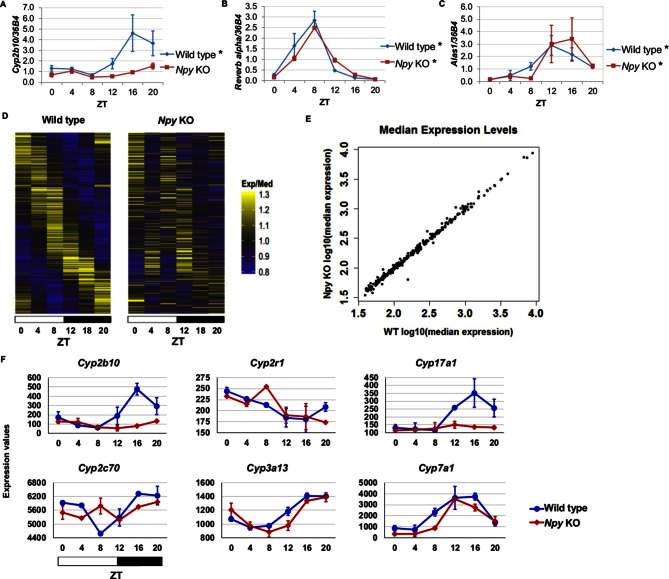
Npy regulates circadian expression of cytochrome P450 genes in the murine liver.(A–C) Quantitative PCR analysis in murine livers. Daily oscillations of Cyp2b10 expression (A) are abolished in Npy KOs compared to their background controls (wild type), while oscillations of the circadian gene, Reverb alpha (B), are unaffected. (C) Levels of another liver clock-independent gene, Alas1, are similar in wild type and Npy KO, suggesting Npy does not regulate its rhythmicity. For qPCR data, n=3–4 mice for each genotype and time point. Transcript levels were normalized to the housekeeping gene 36B4. (D–F) Microarray analysis was used to detect transcript expression in livers of Npy KO and their background controls collected over the course of 24 hr in LD. (D) The heatmap includes transcripts that oscillate in wild type but not in Npy KO liver. Data represent the average transcript abundance from n=2 samples for each genotype and timepoint. Here, the MetaCycle p-value cutoff of p<0.01 was used to identify cyclic transcripts; p>0.8 was considered not cyclic. (E) The median expression values of the wild type-only cyclic transcripts are not different between Npy KO and wild type. (F) Daily expression values of cytochrome P450 genes from microarrays. Cytochrome P450 genes Cyp2b10, Cyp2r1, Cyp17a1, and Cyp2c70 are cylic in wild type liver but are not cyclic in Npy KO liver. Cyp3a13 and Cyp7a1 cycle robustly in both wild type and Npy KO. Graphs show average ± SEM. ZT- Zeitgeber Time.DOI:
http://dx.doi.org/10.7554/eLife.13552.01310.7554/eLife.13552.014Figure 5—source data 1.Data for qPCR and microarray analysis in wild type and Npy knockout mouse liver.